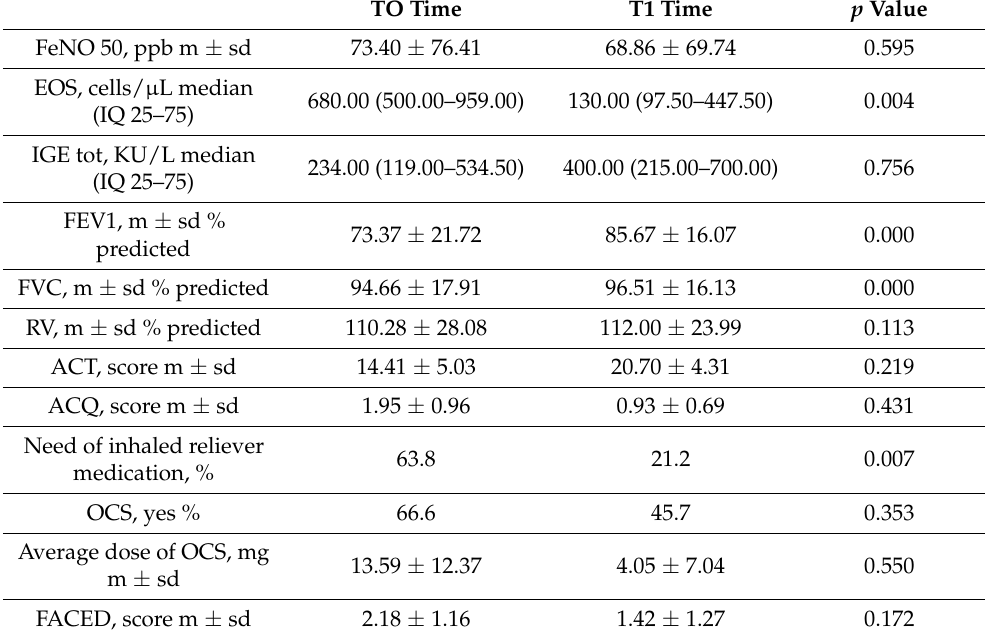
Table 2. Comparison of the entire population between the time T0 and